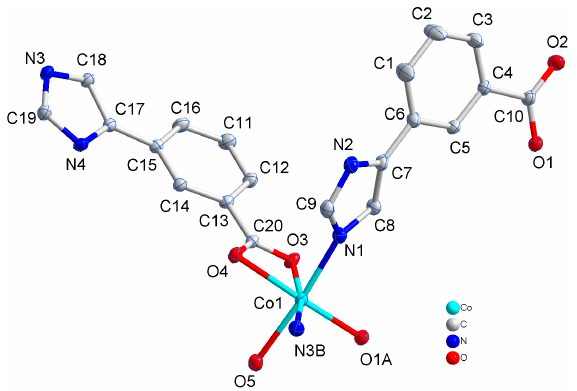
Figure 5. The coordination environment of Co(II) ion in 2 with the ellipsoids drawn at the 30% probability level. The hydrogen atoms are omitted for clarity. Symmetry code: A 1 − x, 2 − y, 1 − z, B 2 − x, 0.5 + y, 1.5 − z.